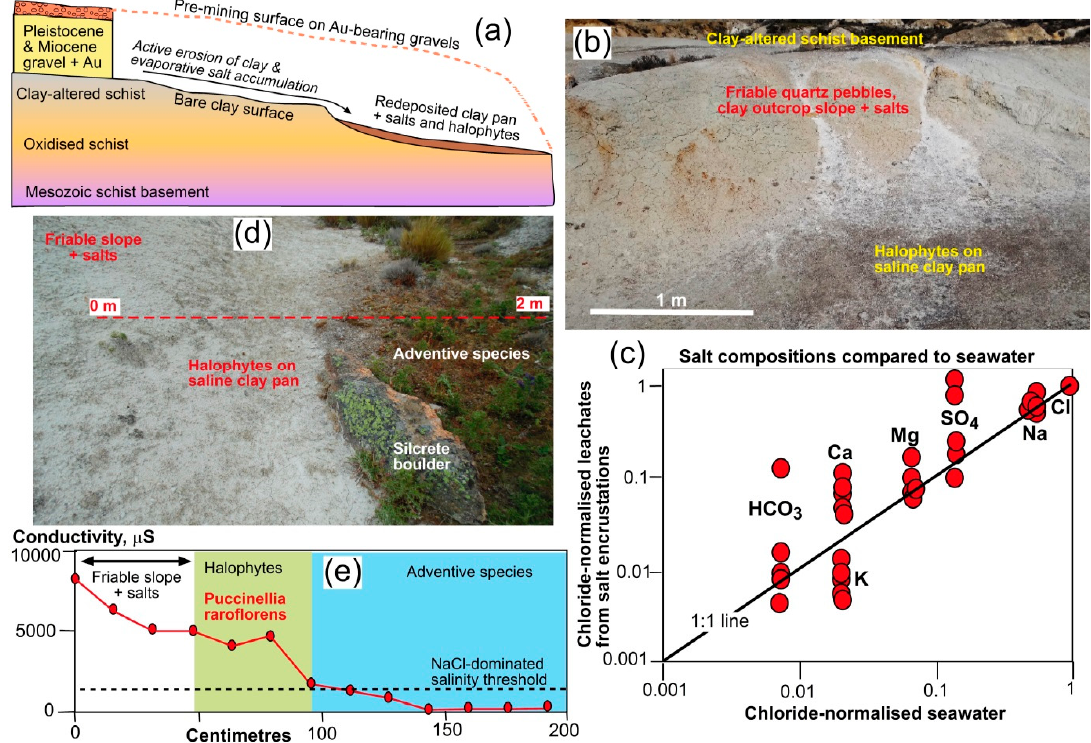
Figure 5. Chapman Road placer gold mine. ( a ) Sketch cross section showing the principal features at present, in relation to the premining topography. ( b ) Photograph of halophyte plants on a salt-encrusted active outwash pan at the foot of a scarp of clay-altered schist left by the miners. ( c ) Compositions of five leachate water samples from salt-rich substrates, normalised to the chloride concentrations and compared to chloride-normalised sea water [27]. ( d ) Photograph of the boundary between vegetation by adventive species and saline substrate with abundant halophyte colonisation. ( e ) EC measurements obtained from substrate samples collected along the taped transect in ( d ).